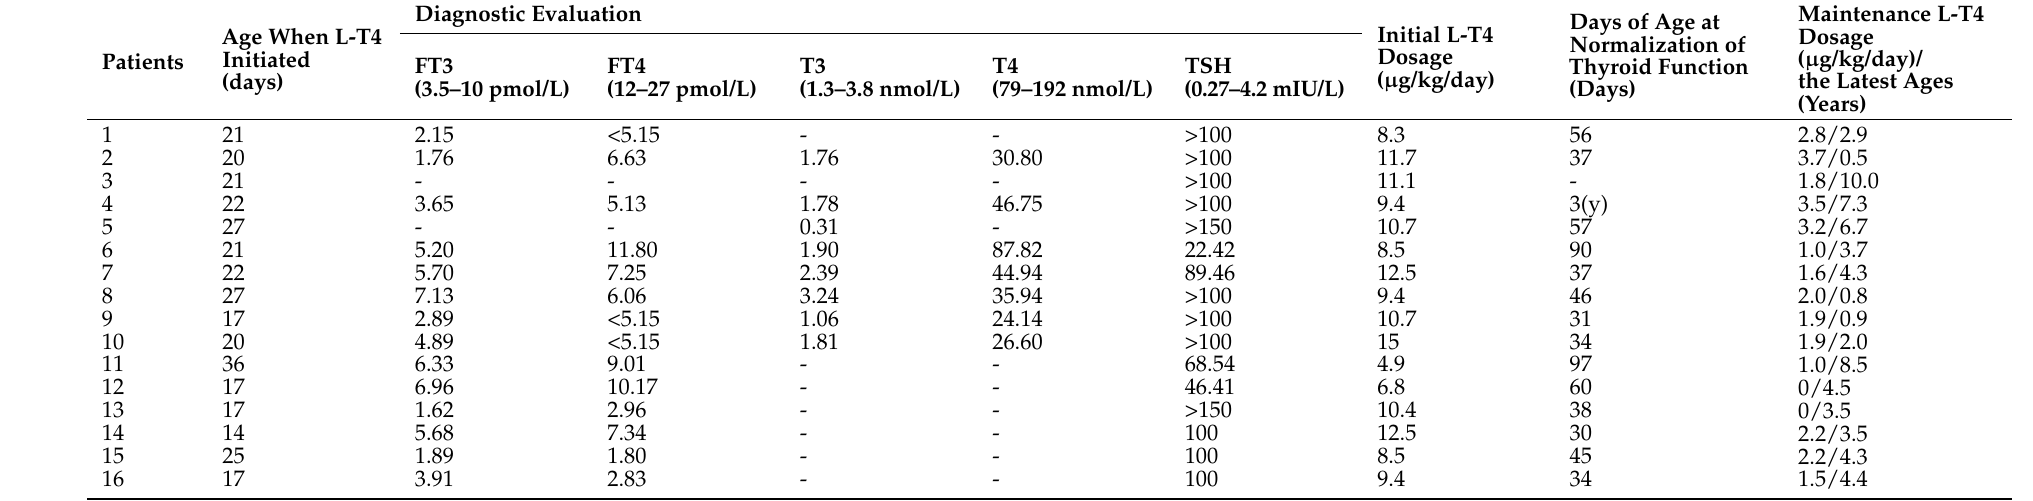
Table 3. Thyroid function indices over time in the 33 CH